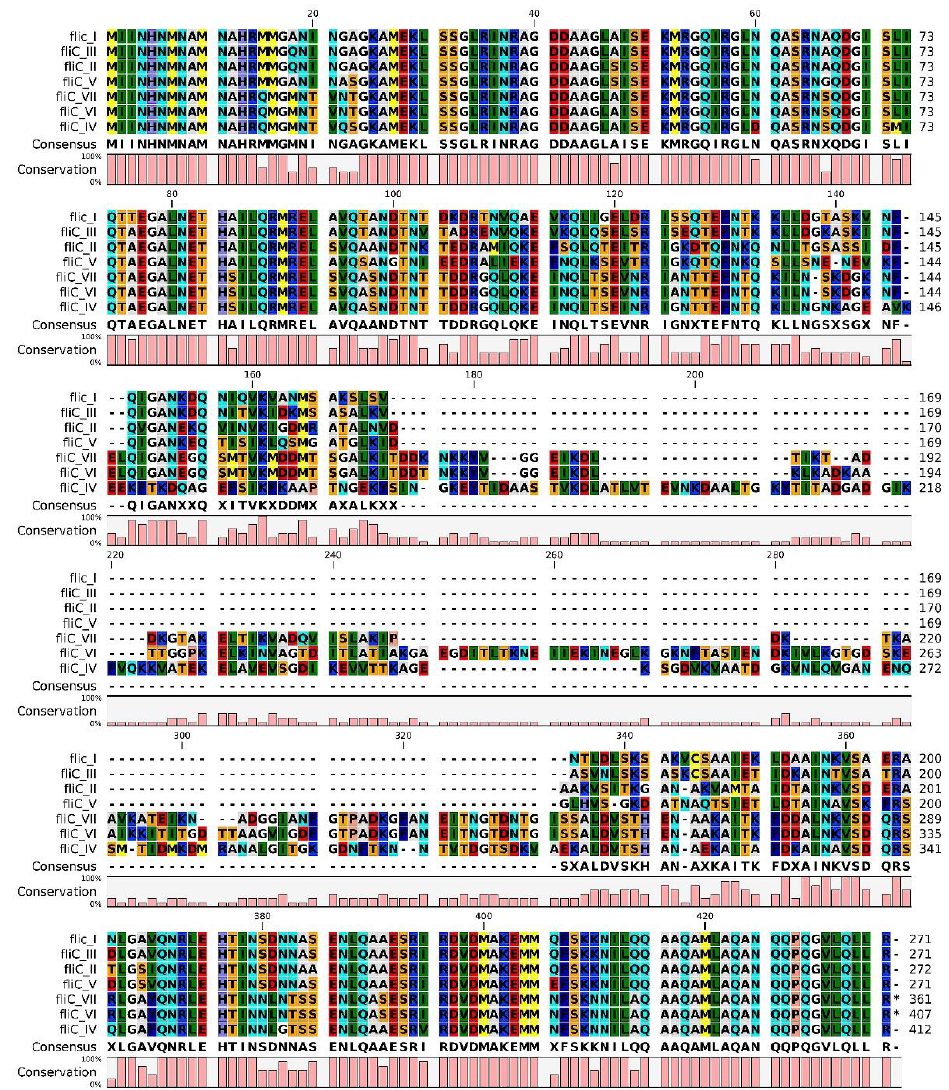
Figure 4. Alignment of the fliC type aminoacidic sequences.